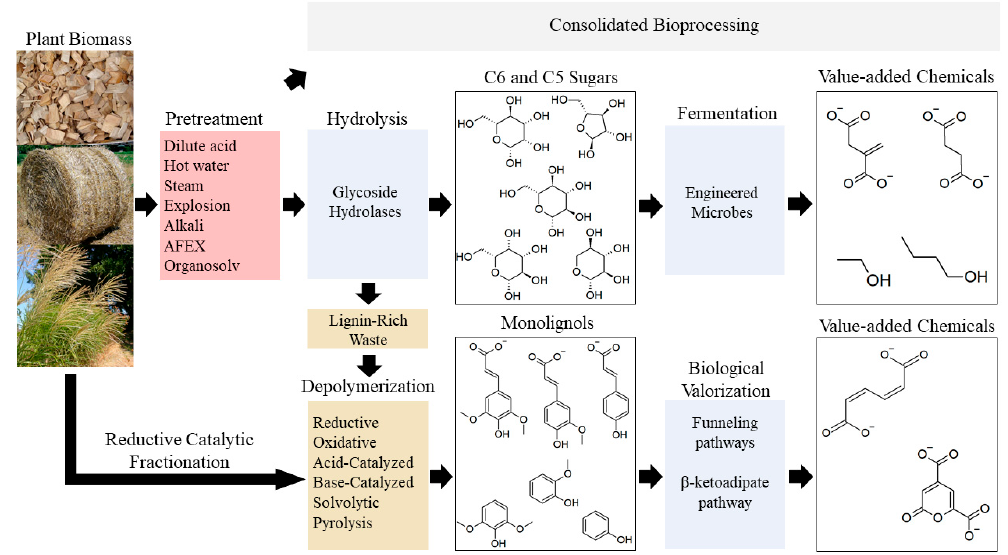
Figure 1. Process diagram of lignocellulosic biofuel production. Plant biomass is pretreated to loosen the cell wall structure for enzymatic hydrolysis and the release of fermentable sugars from structural polysaccharides, such as cellulose. Sugars are then fermented into biofuels or other chemical products. Pretreatment, enzymatic hydrolysis, and fermentation can theoretically be performed together via consolidated bioprocessing using specialized microbes. Lignocellulose biorefining generates a lignin-rich waste stream that can be depolymerized using a variety of techniques. Lignin depolymerization can alternatively occur prior to carbohydrate extraction using techniques such as reductive catalytic fractionation. Lignin depolymerization generates complex mixtures of lignin-derived monomers that can be microbially converted to value-added chemicals, thus increasing the value of these waste streams.